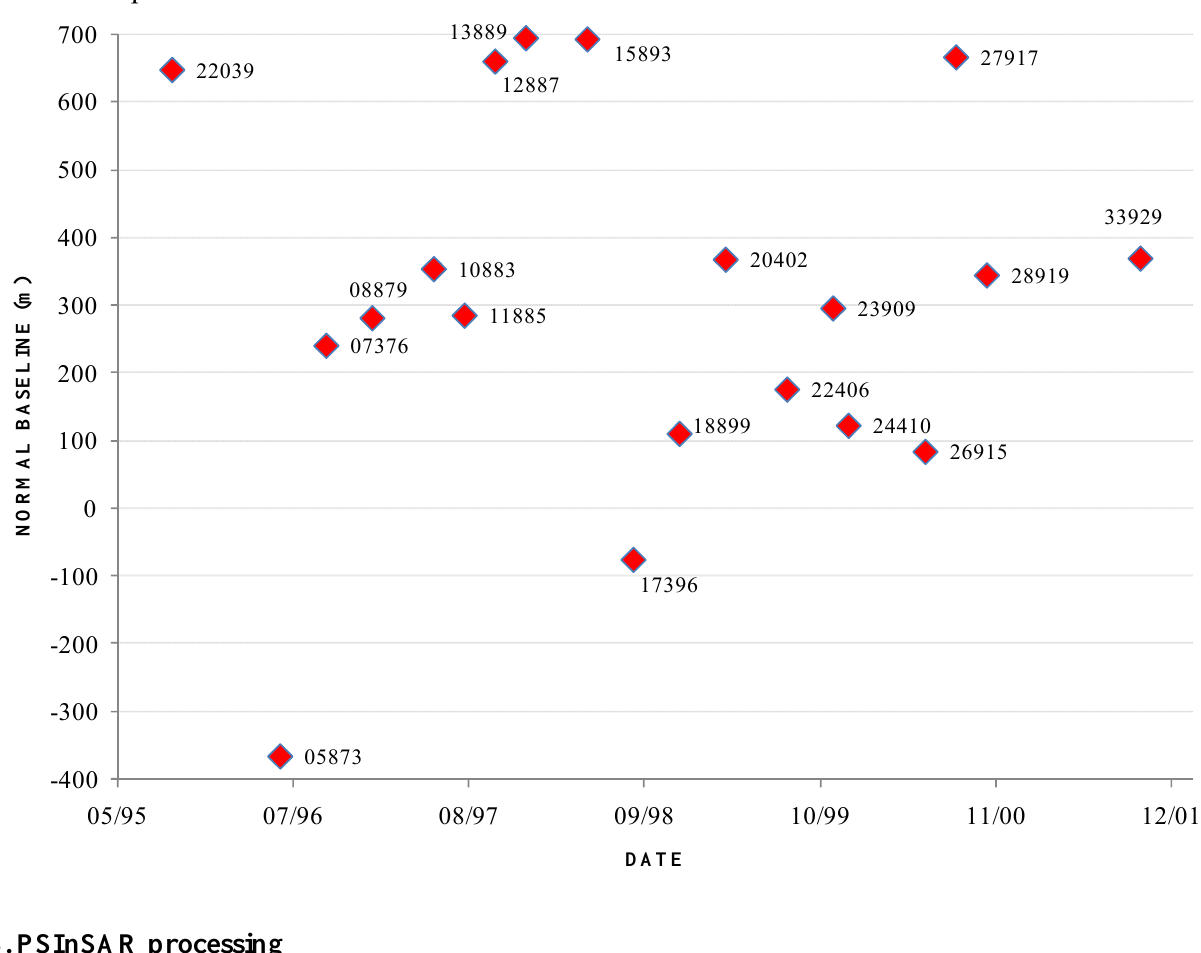
Figure 2 . Normal baselines versus the acquisition dates of the scenes. The figure labels correspond to the ERS orbit number of each